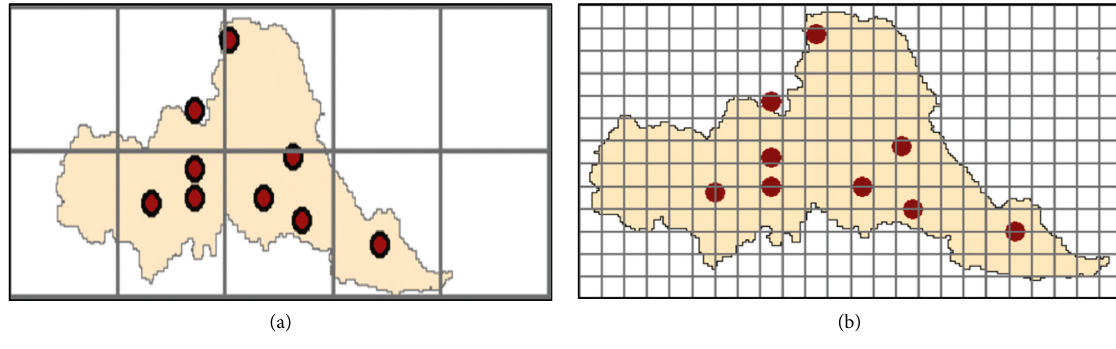
Figure 3: Spatial distribution of rain gauge